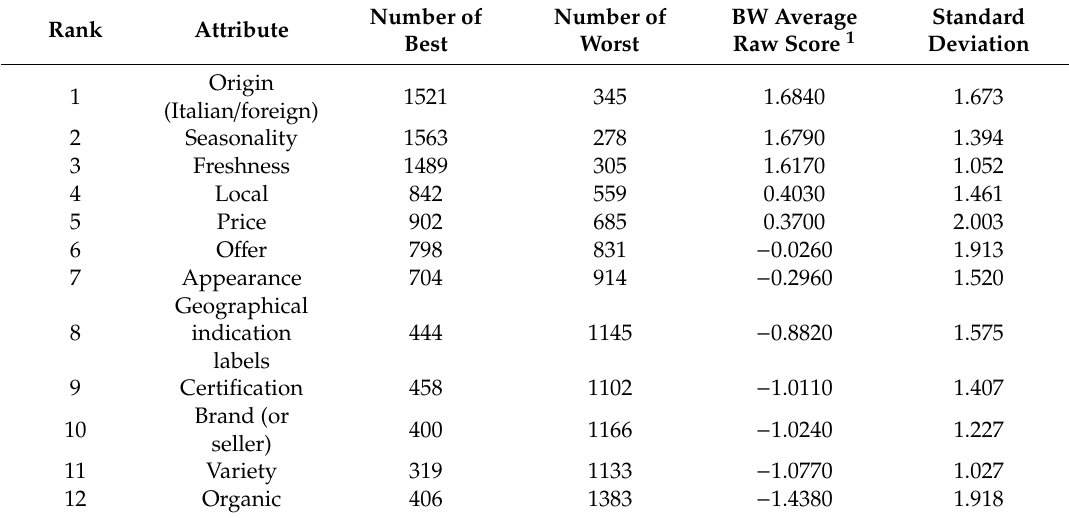
Table 4. Best–worst scaling count report (number of BEST and number of WORST), BW average raw score (A-RS), and standard deviation for each considered